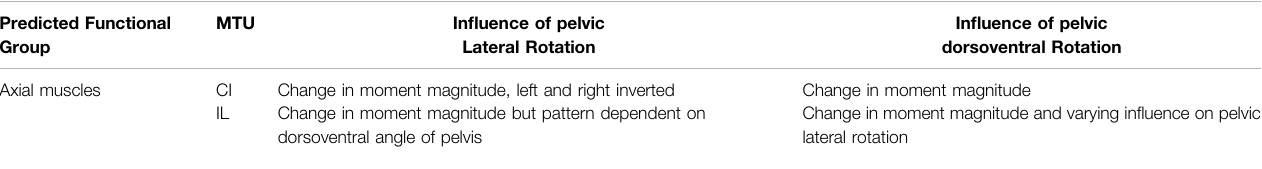
TABLE 3| Results ofhypothetical simulationsHYP_01, HYP_05, and HYP_06 describing thein fl uence ofpelviclateral rotation and pelvicdorsoventralrotationon thelateral rotation moment arms of the axial muscles. Predicted Functional